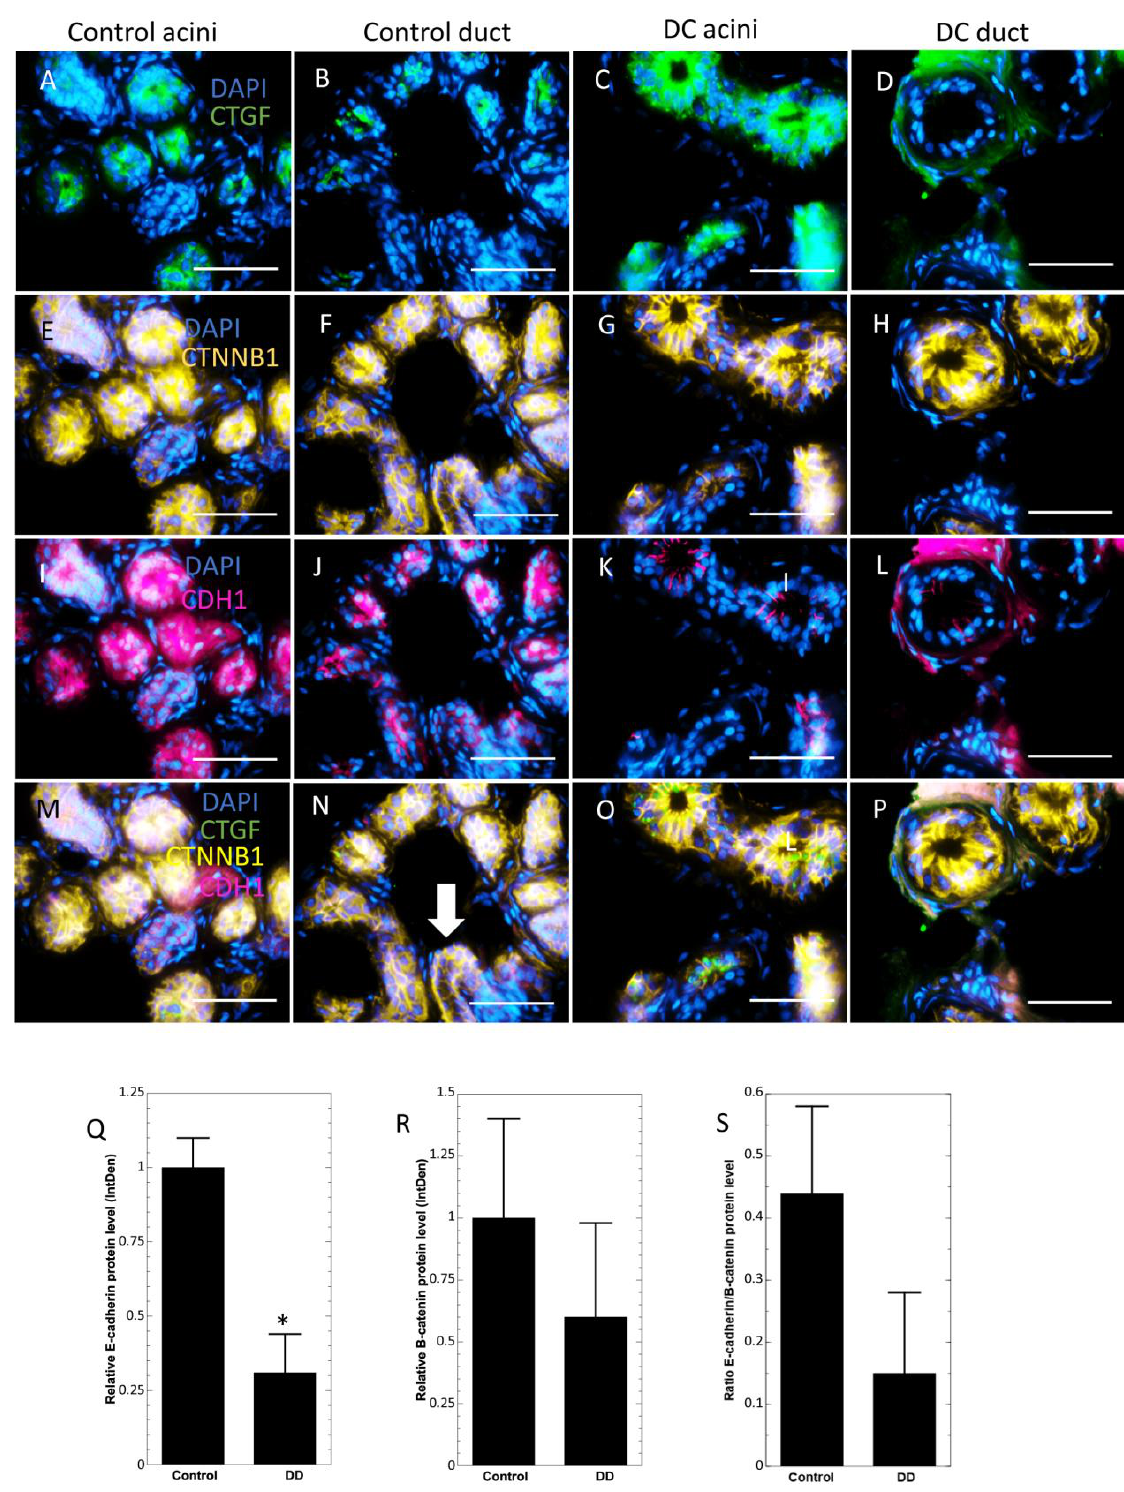
Figure 3. Sweat glands of Dupuytren’s contracture samples present low levels of E-cadherin. Im- munofluorescence analysis of control sweat gland acini ( A , E , I , M ) and duct ( B , F , J , N ) DC sweat gland acini ( C , G , K , O ) and duct ( D,H , L , P ) samples were stained for CTGF ( A – D ), β -catenin ( E – H ), E-cadherin ( I – L ) and merged ( M – P ). E-cadherin and β -catenin colocalization (orange color). Scale bar: 50 µm. Quantitative analysis of E-cadherin ( Q ), β -catenin ( R ) levels in control and DC samples, and E-cadherin/ β -catenin ratio ( S ). The duct in N is marked with a white arrow. Results are presented as mean ± SD and compared to control samples. * p <